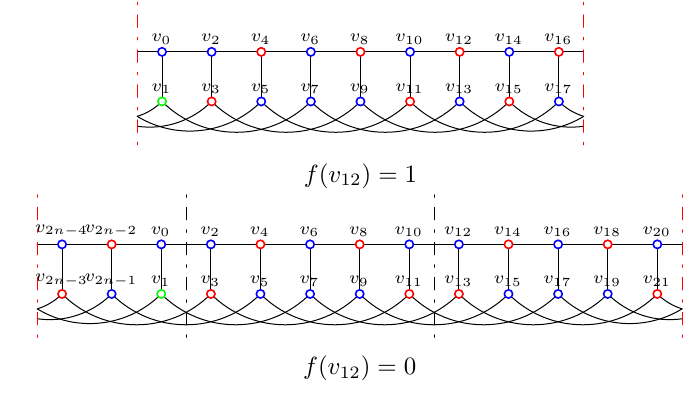
Figure 8. Segments of f in Case 2.2 in Lemma 7.